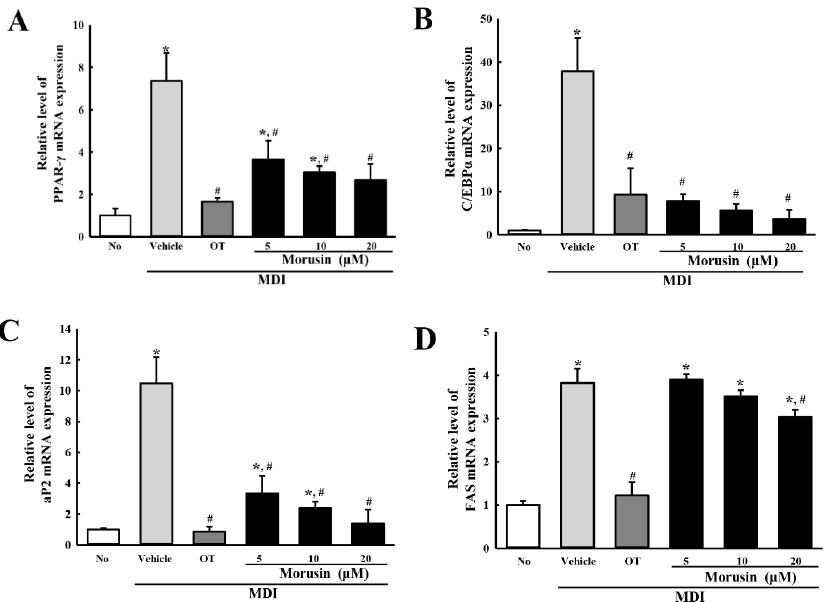
Figure 2. mRNA analysis of adipogenic and lipogenic factors. The mRNA levels of two